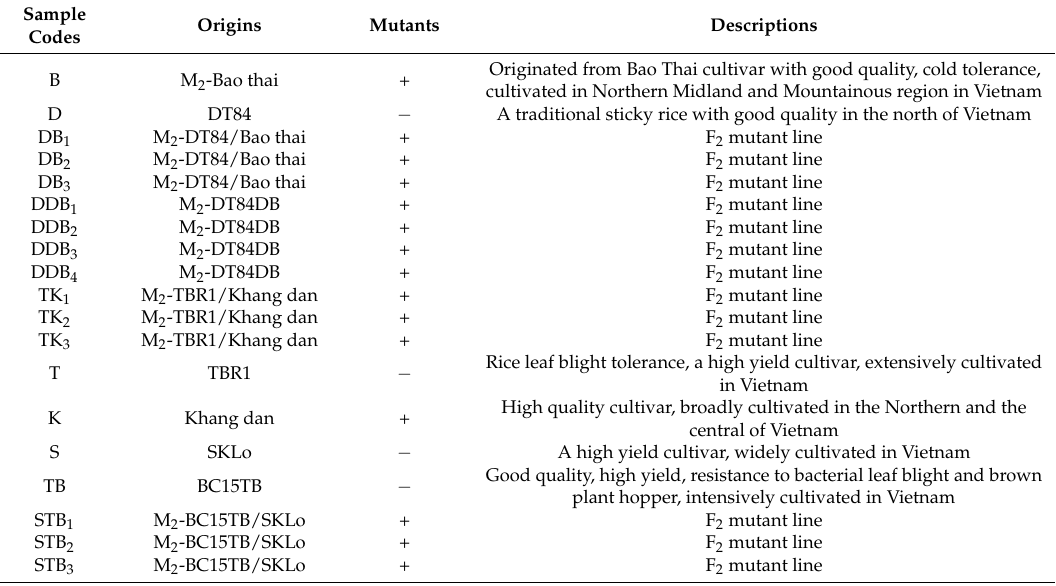
Table 1. List of rice